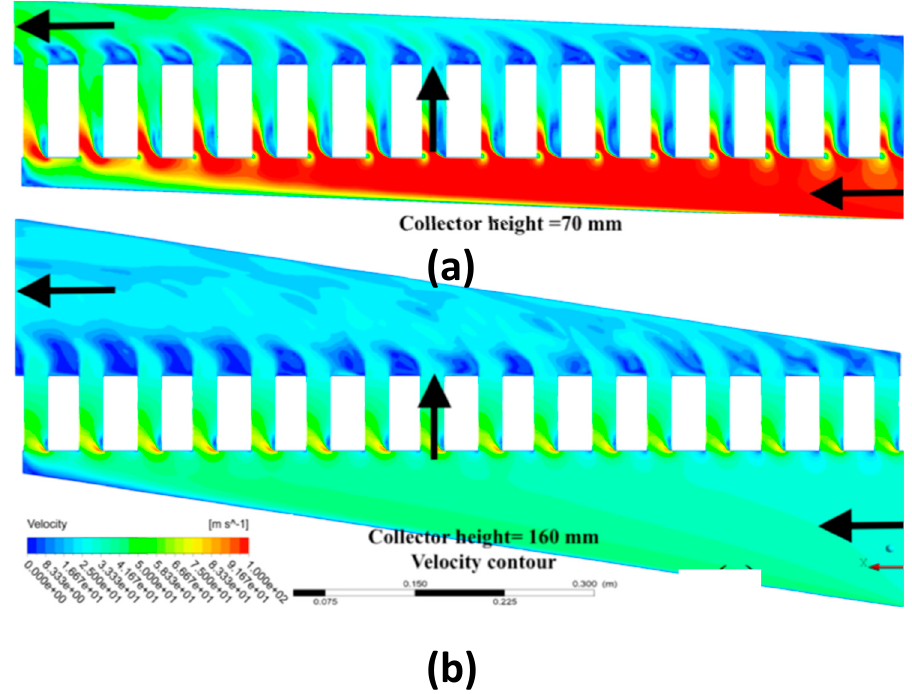
Figure 7. Velocity contour height = 50 mm ( a ); velocity contour height = 160 mm ( b ).